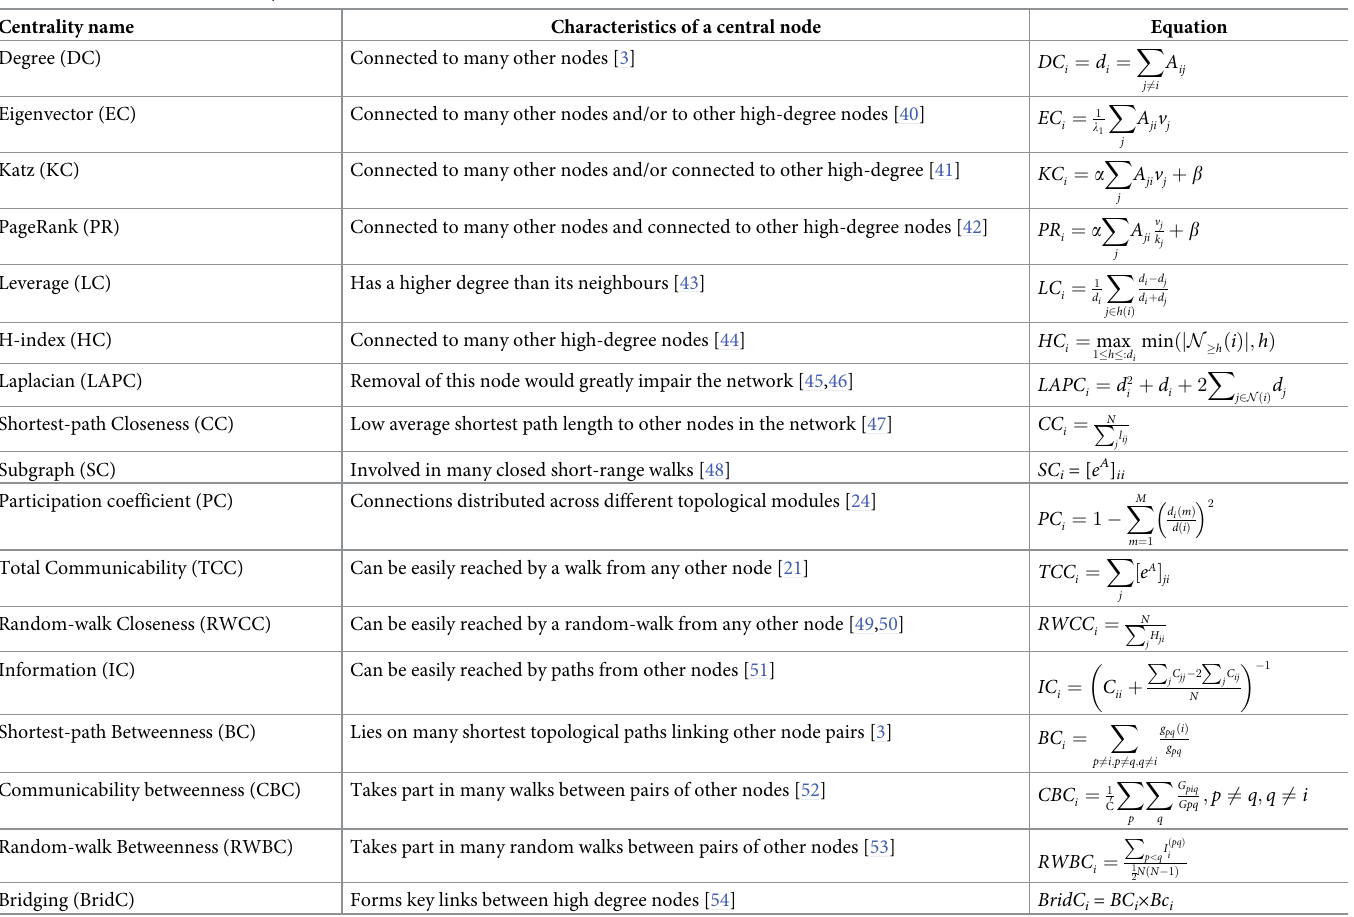
Table 1. Definitions for centrality